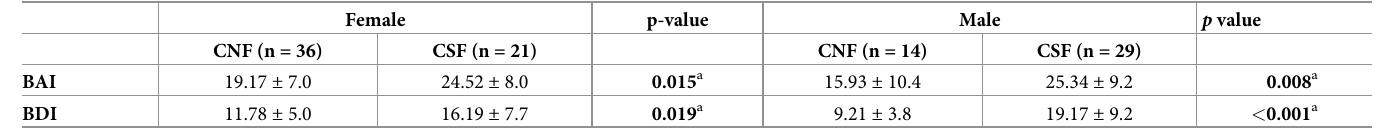
Table 4. Gender stratification.